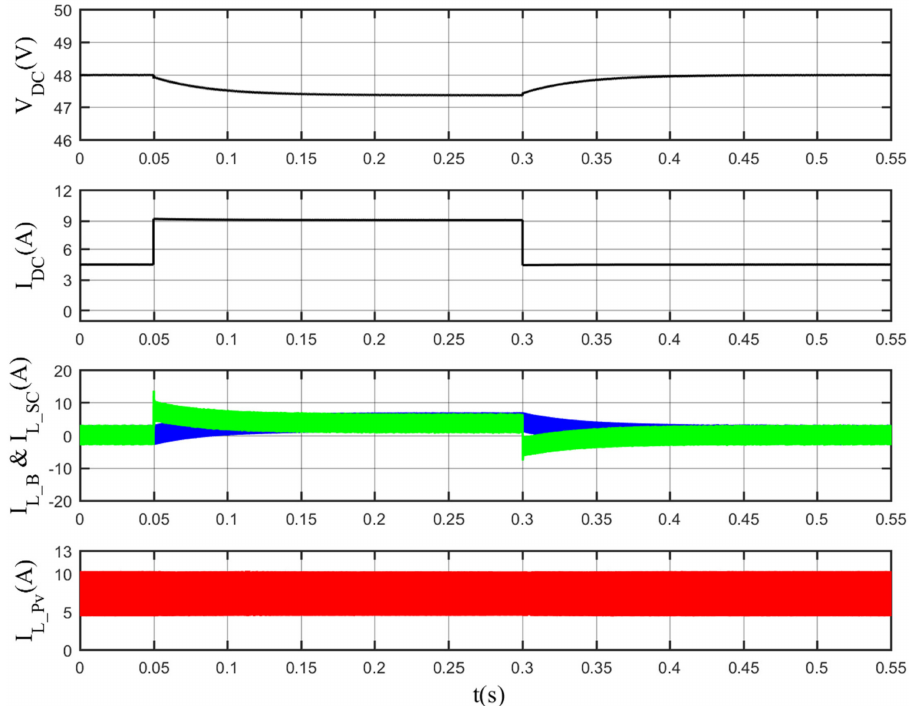
Figure 11. Simulation for dual droop scheme at supercapacitor voltage V SC = 28.44 V when the load changed from 10.8 Ω to 5.2 Ω and back to 10.8 Ω